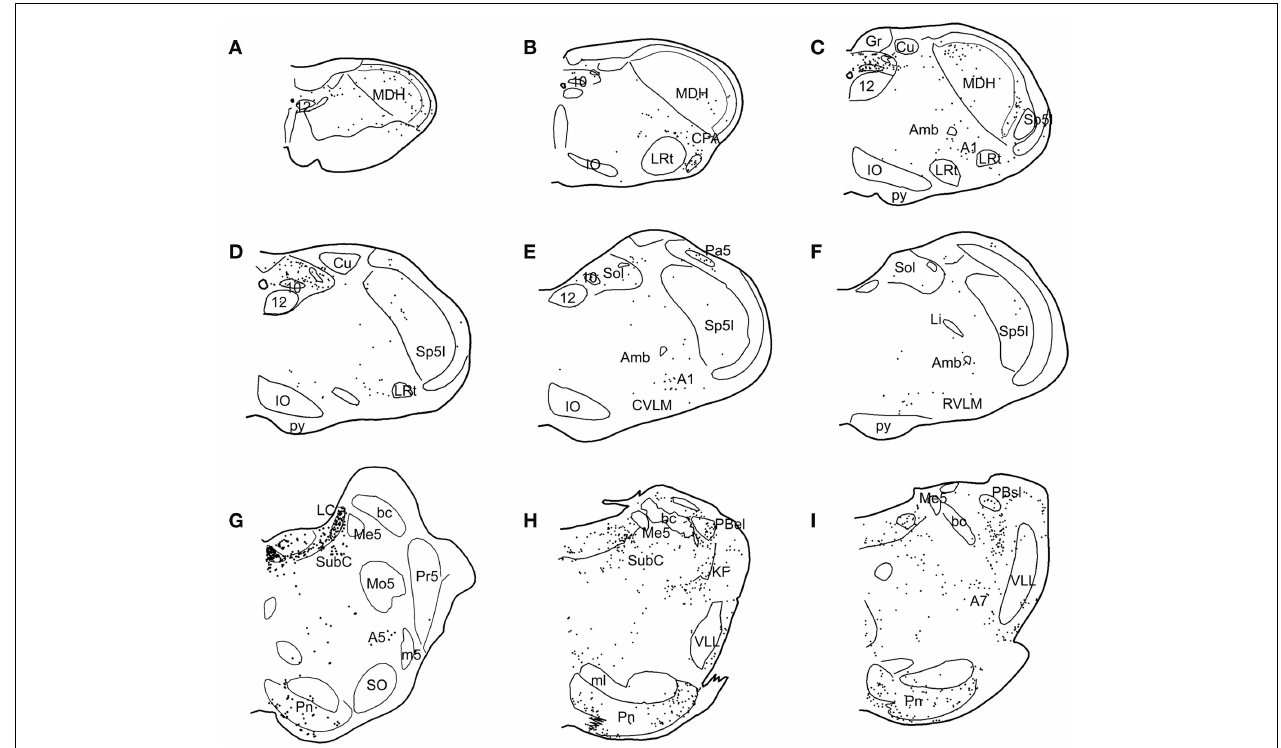
linearis; LRt, lateral reticular nucleus; MDH, medullary dorsal horn; Me5, mesencephalic trigeminal nucleus; Mo5, motor trigeminal nucleus; Pa5,